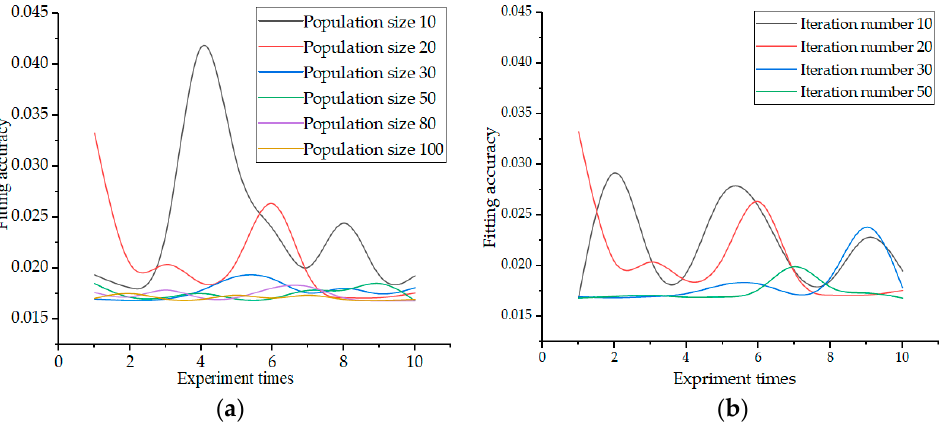
Figure 8. Fluctuation of curve fitting accuracy when ( a ) Max_iter is 20 and W varies from 10 to 100, and when ( b ) W is 20 and Max_iter varies from 10 to 50 .